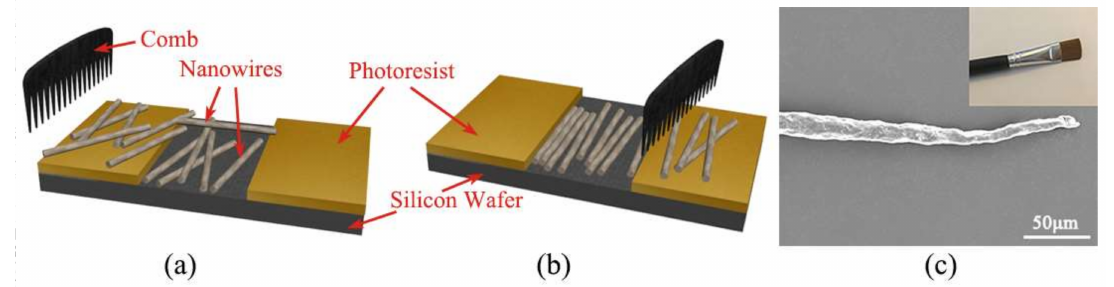
Figure 1. Schematic diagram of the combing process. Nanowires array before ( a ) and after combing ( b ). ( c ) A single brush hair of the makeup brush; the inset shows the makeup brush used in